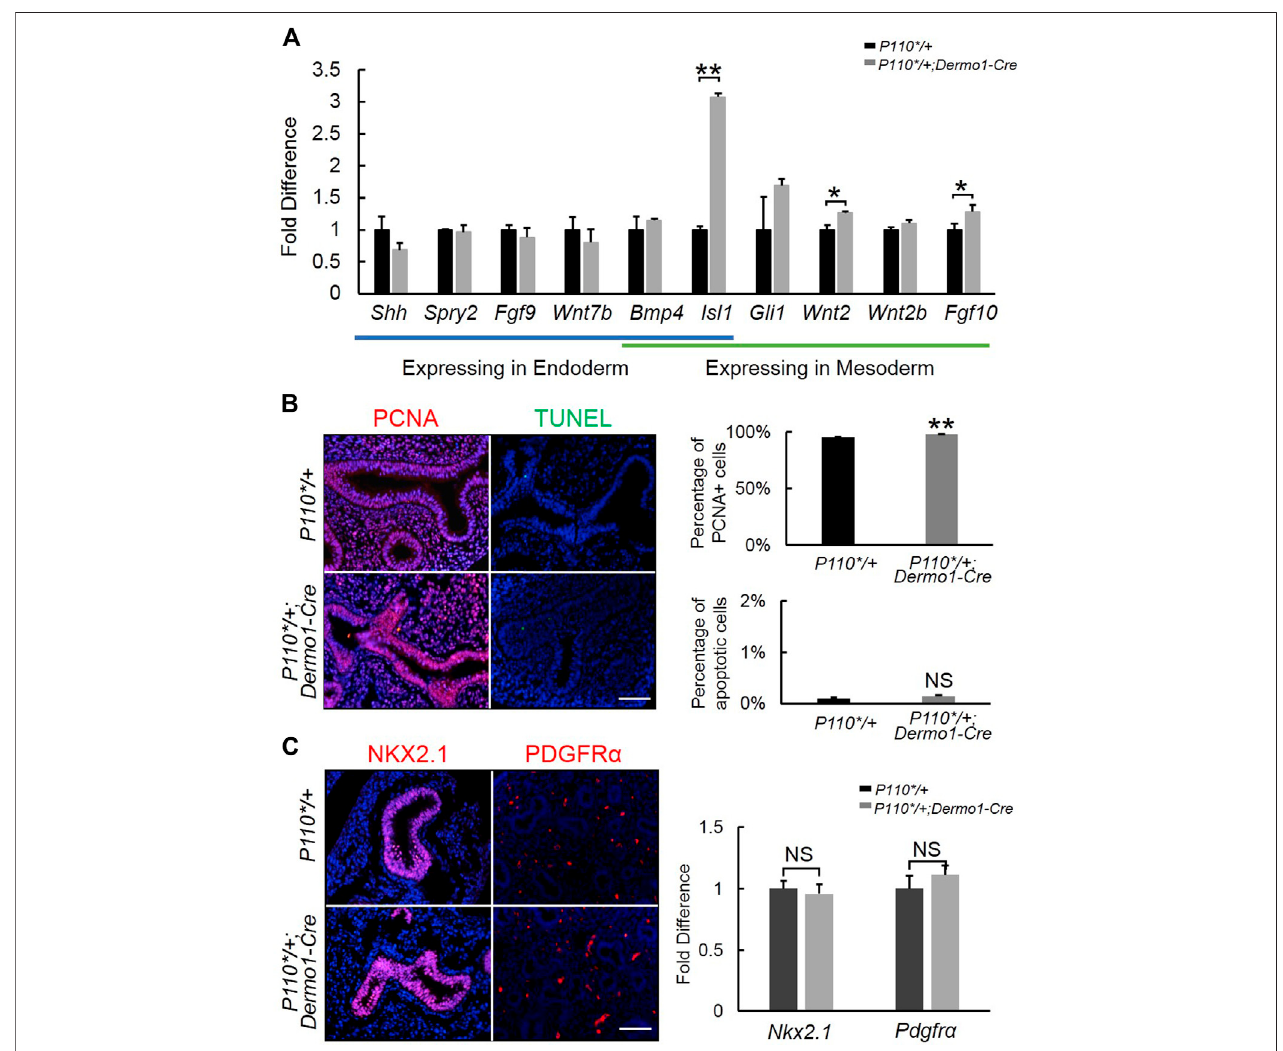
FIGURE 3 | Detection of branching morphogenesis-related genes in early embryonic development. (A) . Real-time PCR analysis of branching morphogenesis- relatedgeneexpression inE12.5controland P110*/+;Dermo1-cre lung. (B) .IFstainingand cellcounting forcellproliferationand apoptosisinE12.5controland P110*/ +; Dermo1-cre lung. (C) . IF staining analysis and real-time PCR analysis of Nkx2.1 and Pdgfr α in E12.5 control and P110*/+; Dermo1-cre lungs. The bars represent the mean ± SD. N > 3. * p < 0.05, ** p < 0.01. Scale bar: 50 μ m.